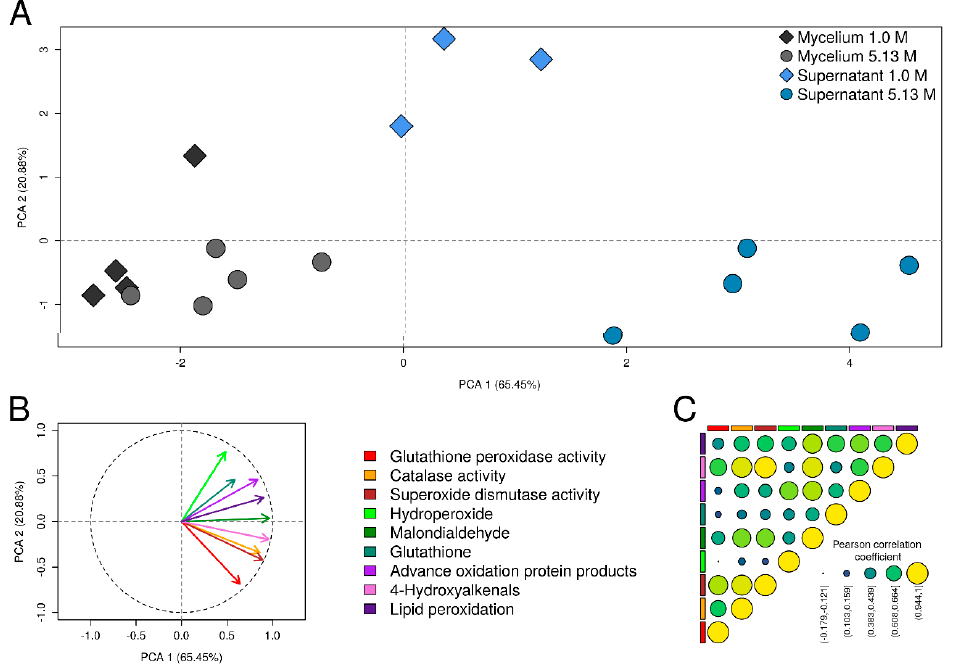
Figure 5. Multivariate statistical analysis of the oxidative stress responses in Aspergillus sydowii EXF-12860. ( A ) Principal component analysis (PCA) plot showing the grouping of mycelium and supernatant samples at 1.0 M and 5.13 M NaCl conditions according to their values of oxidative stress indicators. ( B ) The correlation between oxidative stress biomarkers and the axes of the PCA plot. ( C ) Pearson correlation coe ffi cient of the oxidative stress biomarkers in samples of mycelium and supernatant at 1.0 M and 5.13 M NaCl